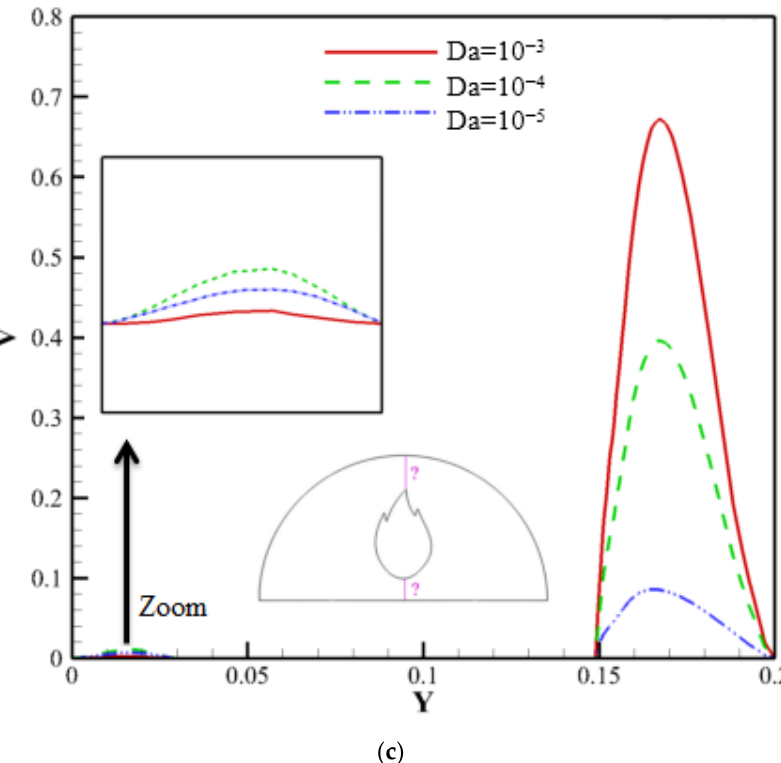
Figure 16. Variation of ( a ) Nusselt number at the enclosure heated length, ( b ) temperature alongside mean vertical location and ( c ) velocity alongside mean vertical location for different values of Da at φ = 0.02, L = 0.2, Ha = 50 and Ra = 10 5 ).